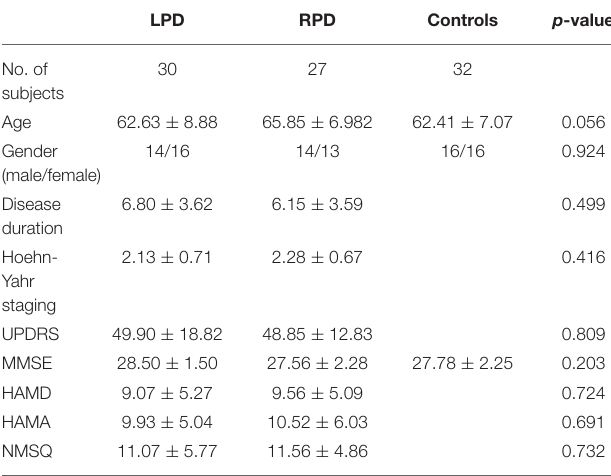
TABLE 1 | Demographic and clinical characteristics of the PD patients and